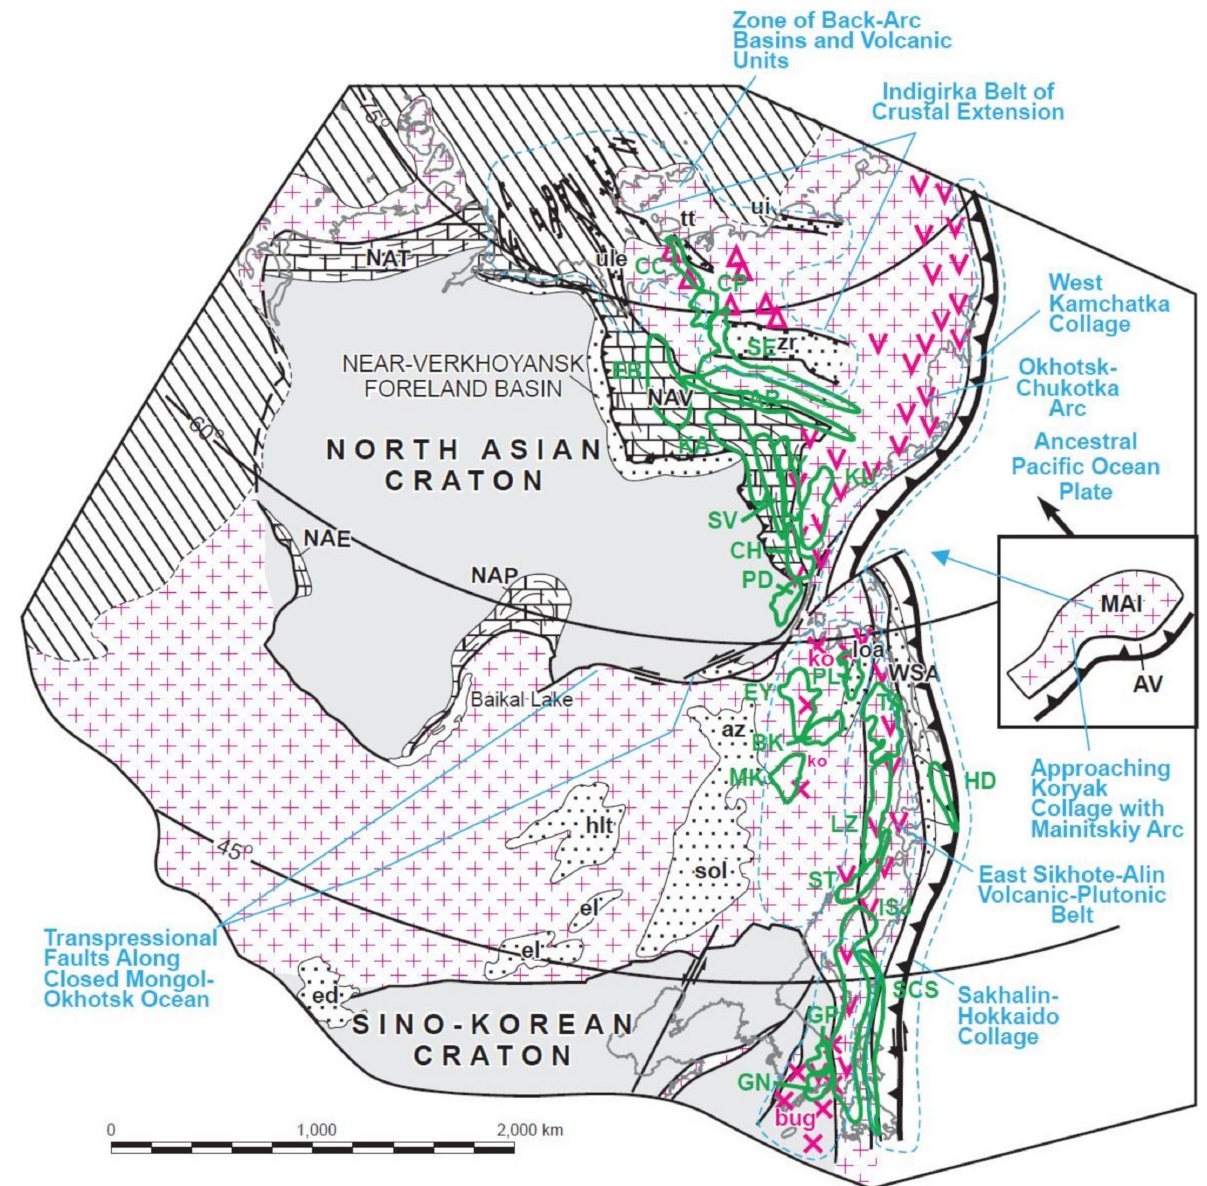
Figure 3. Paleotectonic reconstruction of NE Asia at 87 Ma, showing metallogenic belts of the Late Cretaceous–Paleogene (96–24 Ma) age [4]. North Asian Craton Margins: NAE—East